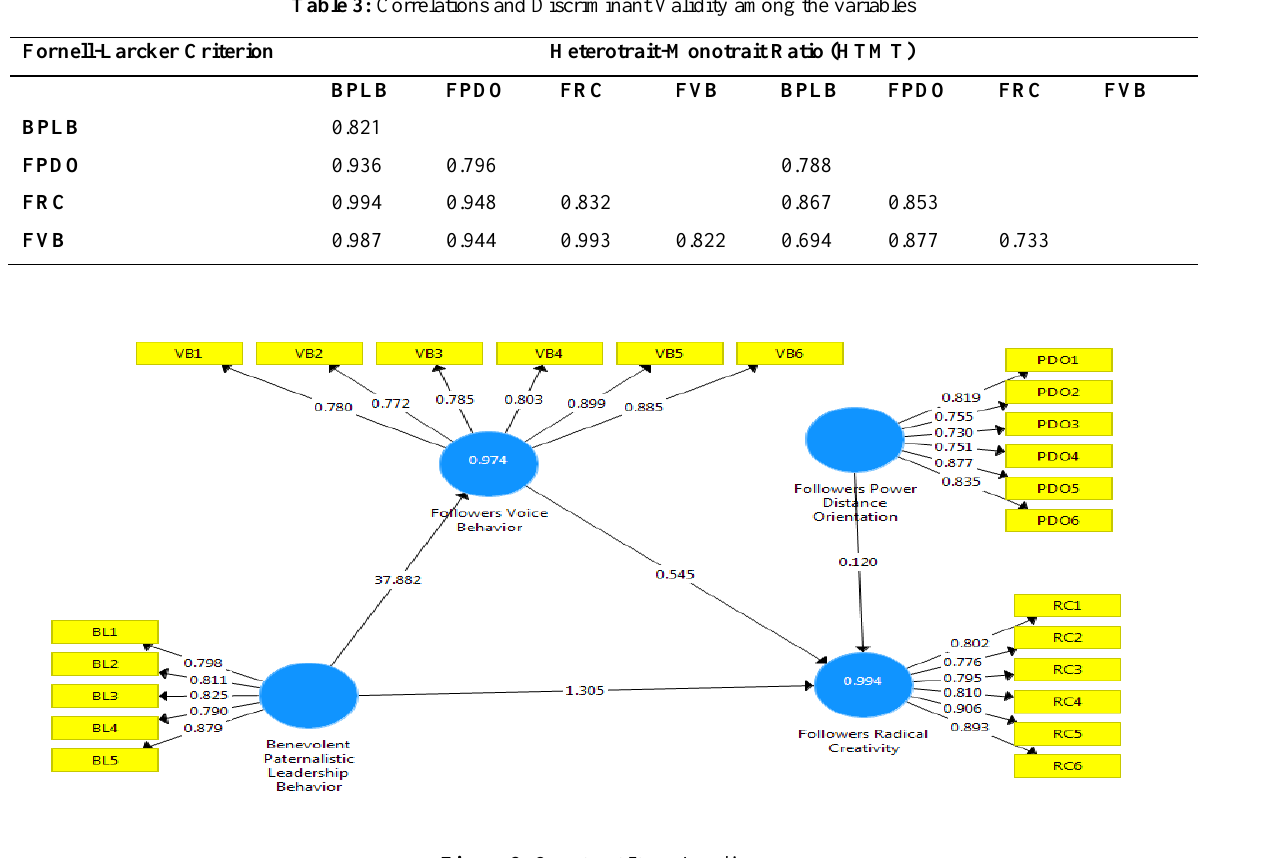
Figure 2: Construct Items